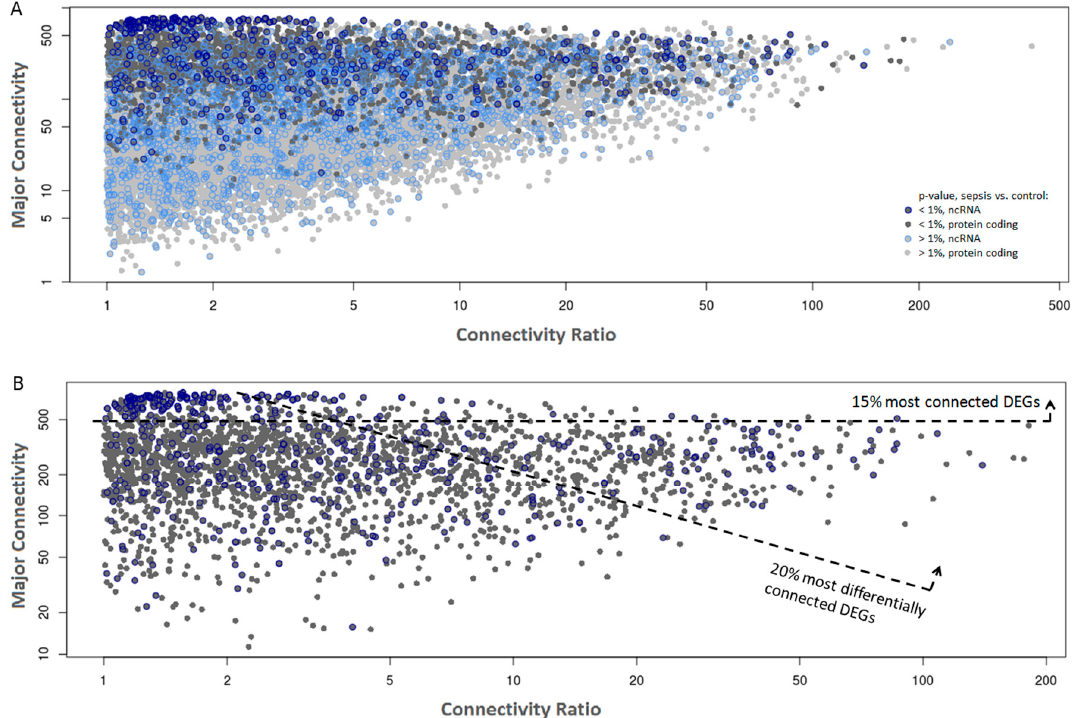
Figure 2. Gene co-expression networks from sepsis and control samples. Each dot represents a gene plotted as a function of its major network connectivity ( y -axis) and the connectivity ratio, which is the ratio between the major connectivity/minor connectivity retrieved from the adult and elderly networks ( x -axis). ncRNAs are marked with a blue circle. ( A ) All detected genes colored by differential expression significance between sepsis and control samples, with differentially-expressed genes (DEGs) indicated by a darker shade; ( B ) Only DEGs ( p ≤ 0.01) are shown. The most connected (top 15%) and most differentially connected (top 20%) genes are highlighted. The top 20% most differentially connected DEGs were selected using the product of the average connectivity in both networks and the connectivity ratio across networks as a cutoff.